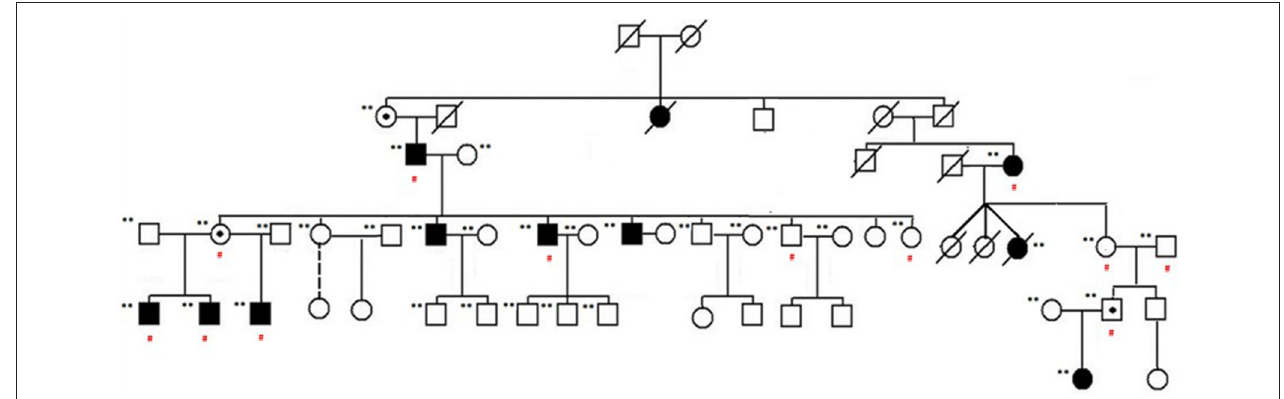
FIGURE 1 | NSCL/P family pedigree. Affected individuals are shown with blackened symbols, and unaffected individuals are shown with open symbols. Samples included in the analysis are marked with ( ** ) beside their pedigree symbols. A dot in the center of a symbol indicates an individual who is an obligate carrier and produced affected children with NSCL/P. Red (#) indicates those individuals exome sequenced as part of this study.